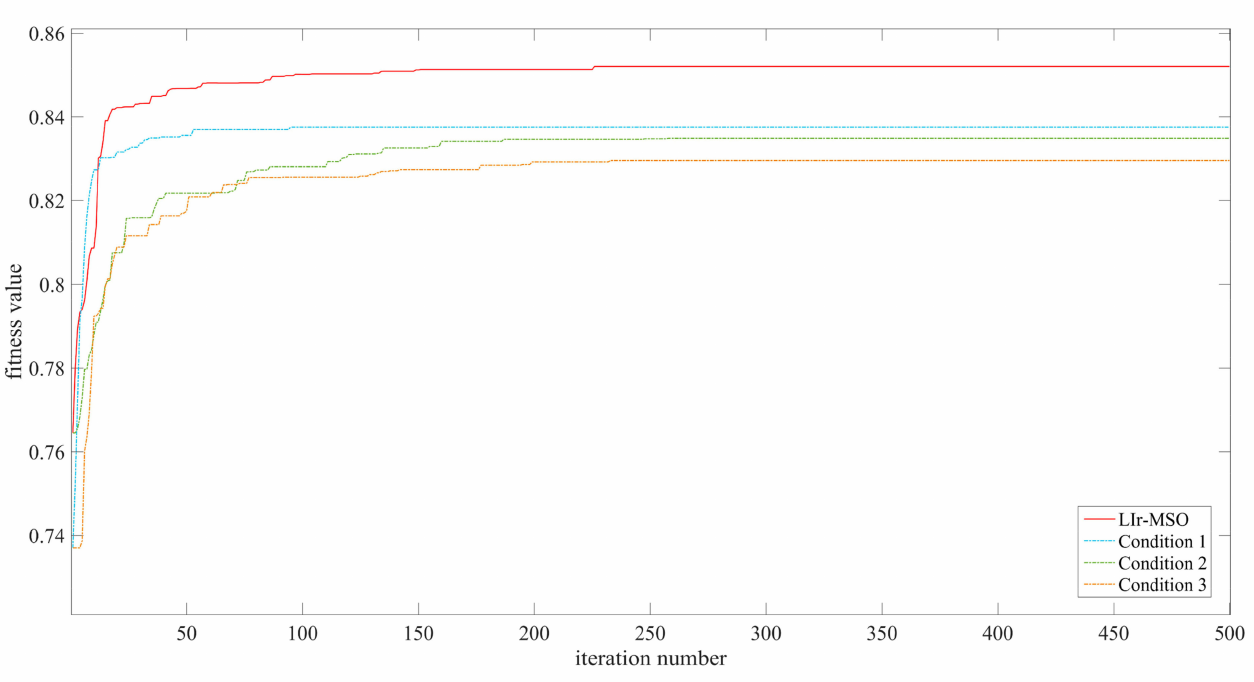
Figure 8. Change in fitness score of the comprehensive model with the number of iterations showing a relatively rapid change up to about 21 iterations followed by a transition toward a much slower phase of increase, punctuated by periods of static fitness. Shorter periods of relatively static change are also noticeable in the rapid phase. The different Conditions refer to the contrast experiments described in the main text: (1) without initialization revision; (2) without mutation revision; (3) without initialization and mutation. LIr-MSO refers to the comprehensive model that includes both initialization and mutation